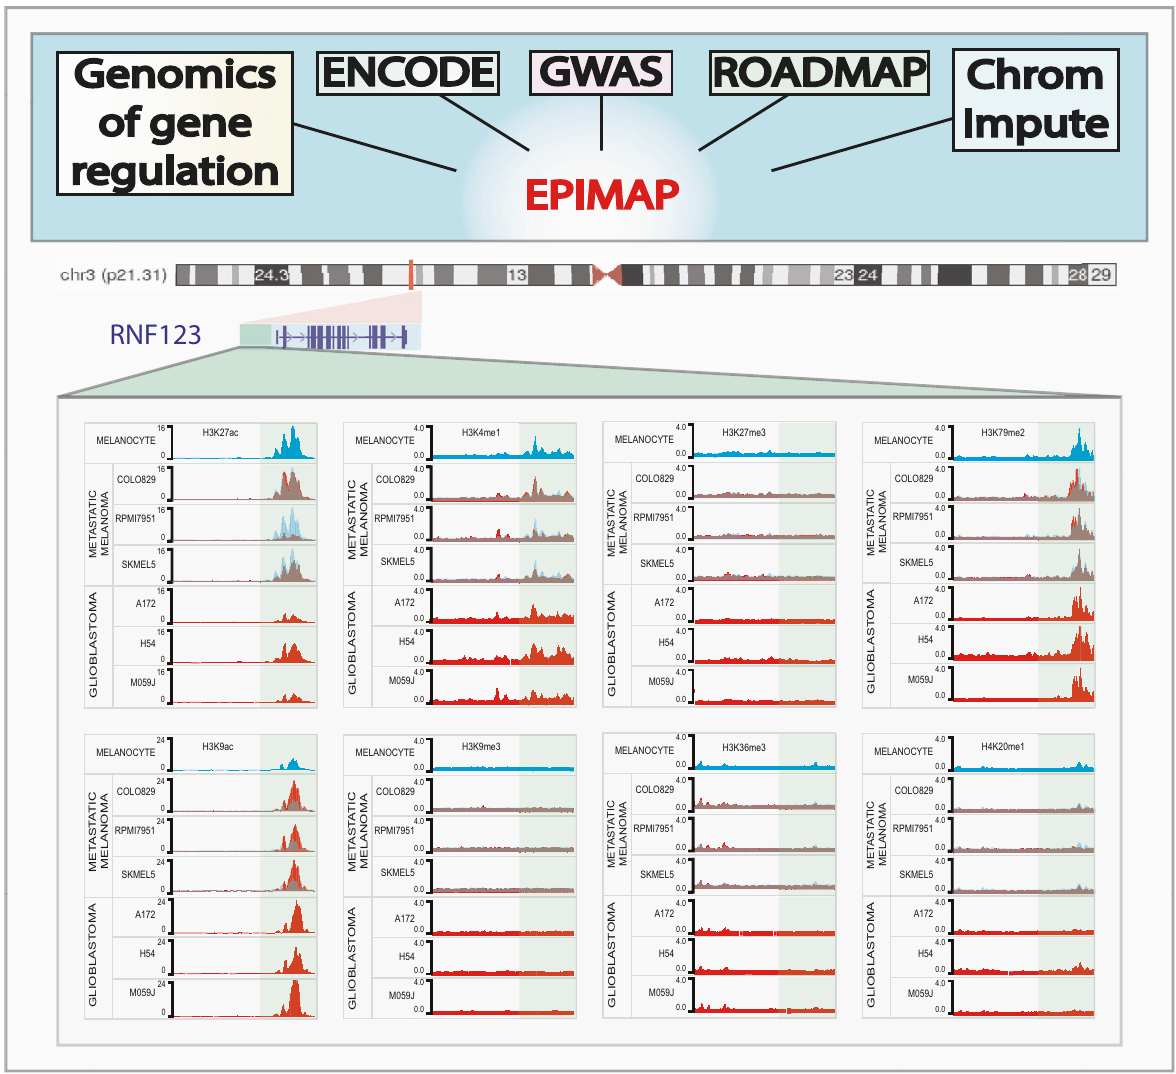
Fig. 1 Histone marks on RNF123 gene obtained from EpiMap. EpiMap is a compendium of epigenomes across multiple annotation projects: Genomics of gene regulation, ENCODE, ROADMAP, GWAS, and Chrom Impute. Presented are the histone modi fi cations at the promoter region of RNF123 gene (Chromosome 3, p21.31) in primary melanocytes (melanocytes), metastatic melanoma (COLO829, SK-MEL5, and RPMI7951) and glioblastoma cell lines (H54, M059J, and A172). All the tracks were downloaded from EpiMap and visualized on WASHU epigenome browser